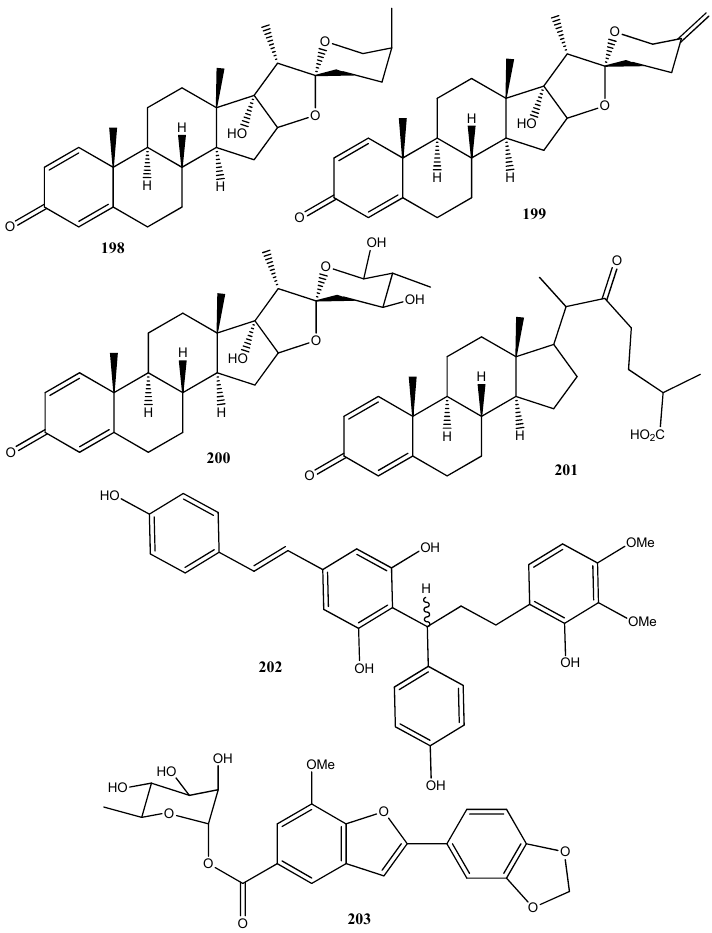
Figure 14. The structures of compounds 198 – 203 .